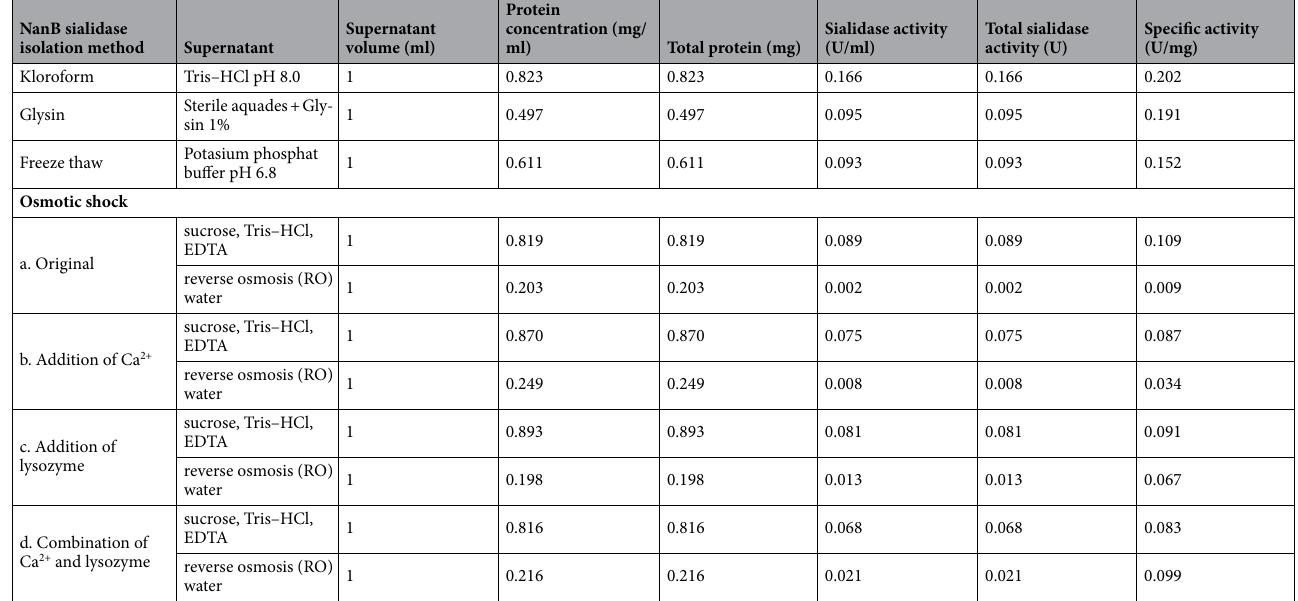
Table 4. Results of testing the specific activity of NanB sialidase from various isolation methods.